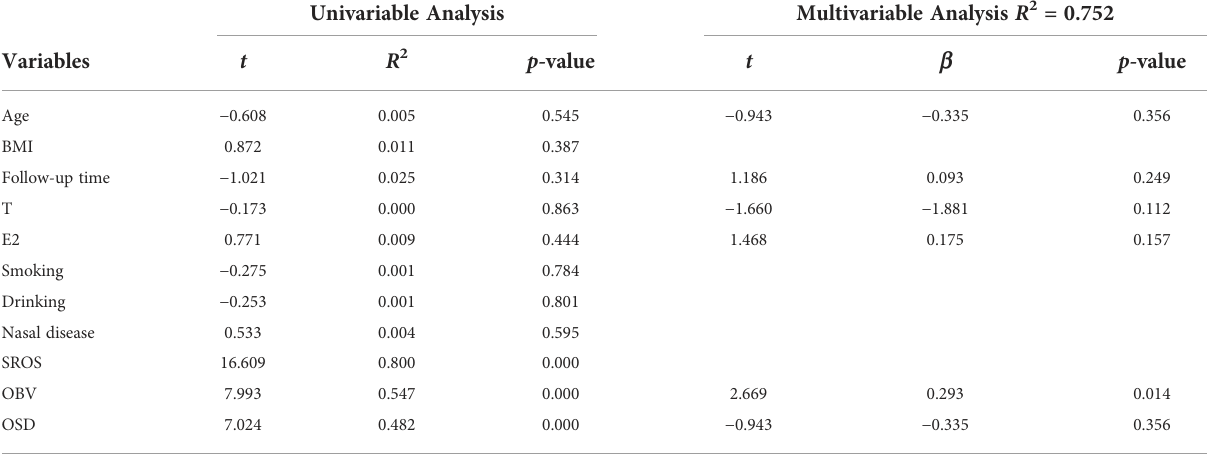
TABLE 3 Univariable and multivariable linear regression analysis for determinants of olfactory function in CHH patients. Univariable Analysis Multivariable Analysis R 2 =